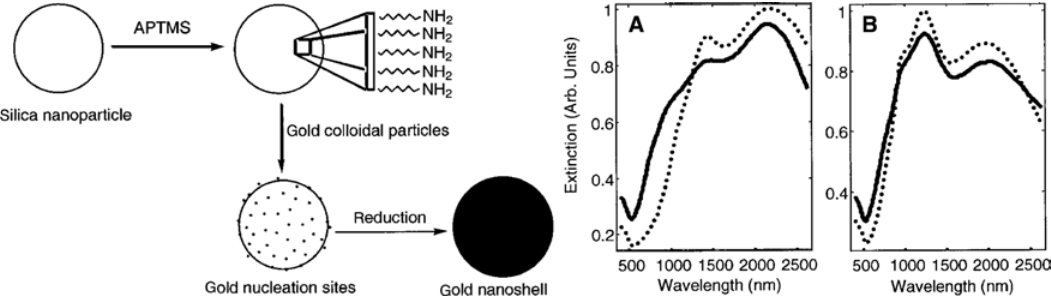
Figure 3: Left: Strategy used to grow a gold nanoshell around a silica nanoparticle core. Reprinted with permission from Ref. [60]. Copyright (2015) American Chemical Society. Right: Spectra of nanoshells with silica seed solution: gold chloride solution (0.38 mm HAuCl (A) 0.6:6.0 and (B) 0.5:6.0 (solid lines). Dotted lines are calculated best fits with a 210 nm silica core and gold shell thicknesses of (A) 6.0 and (B) 10.5. Reprinted with permission from Ref. [61]. Copyright (2015), AIP Publishing LLC.